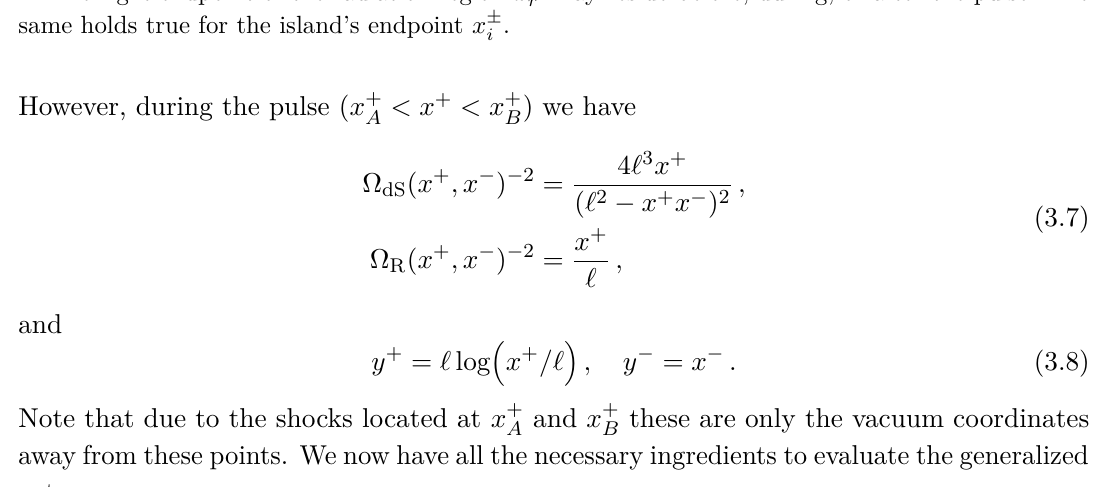
Figure 5 . Computing the generalized entropy of R , we allow for the contribution of an island region I . The right endpoint of the radiation region x ± same holds true for the island’s endpoint x ±